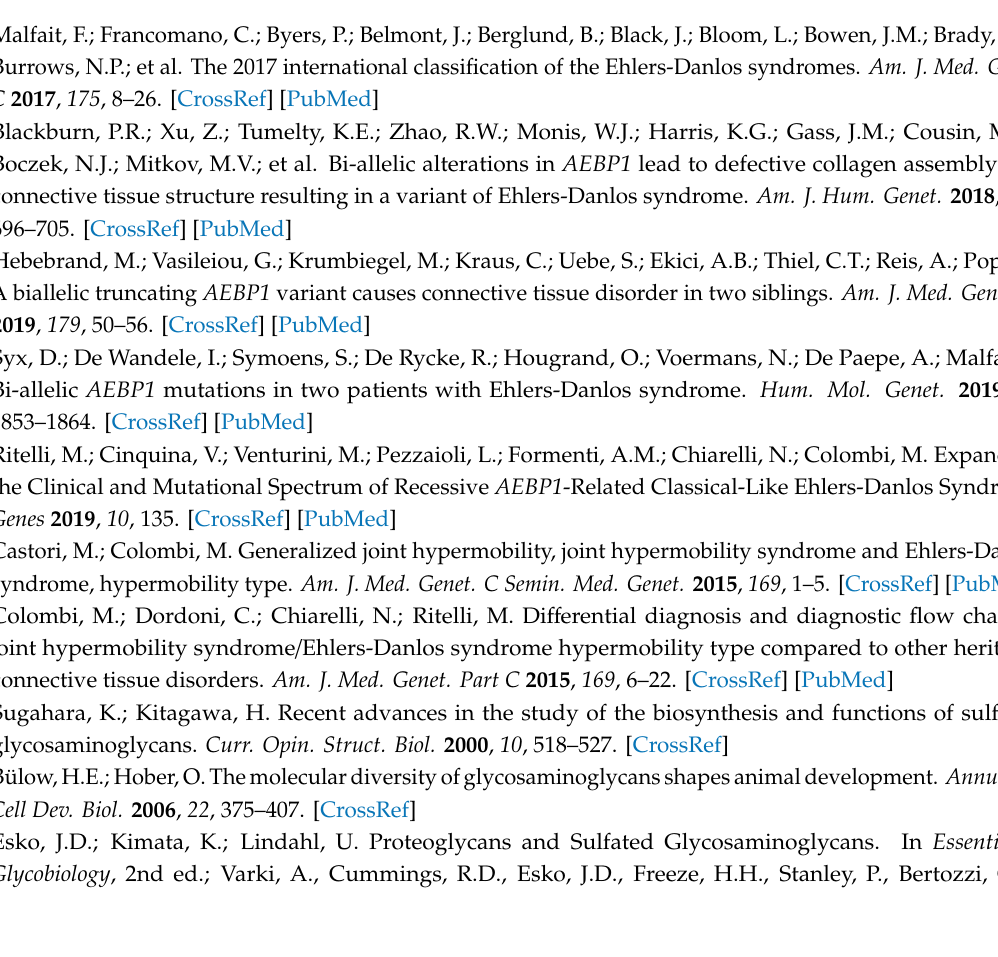
Table S1. Primers. Table S2. Clinical features of the present patient and comparison with spEDS and B4GALT7 -LRS. Table S3. Summary of exome sequencing results. Figure S1. Coverage distribution. Table S4. Variants with perfect segregation among trio